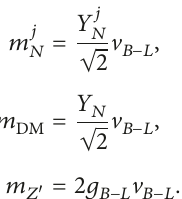
2 parity assignment shown